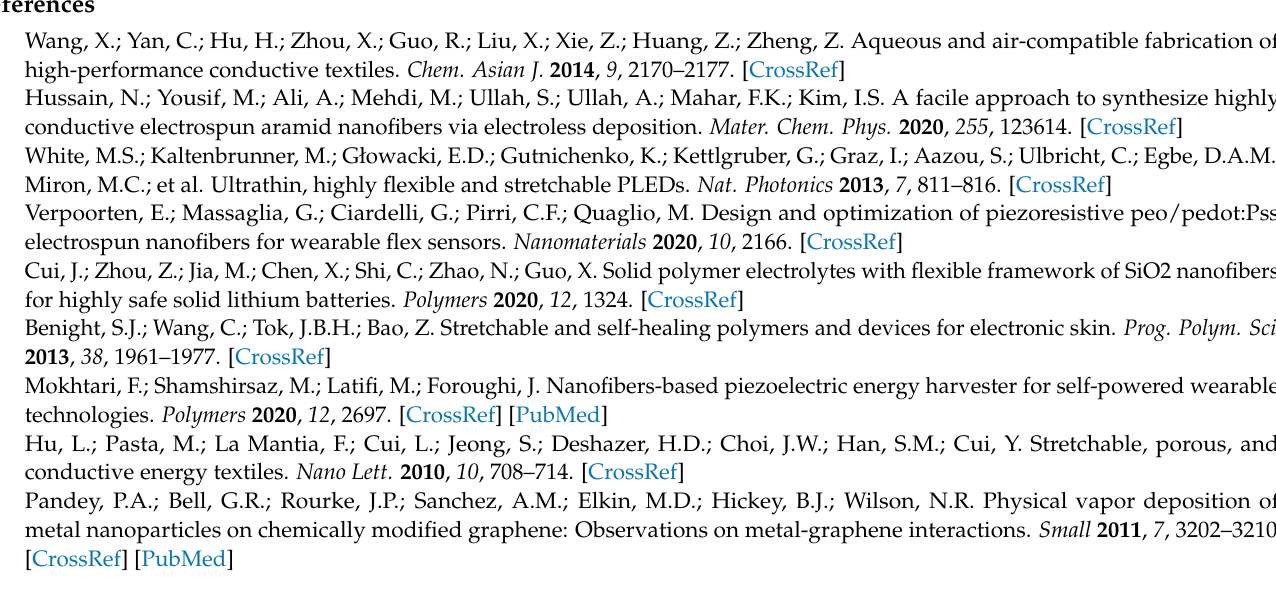
a The shrinkage study was calculated by using Equations (4) and